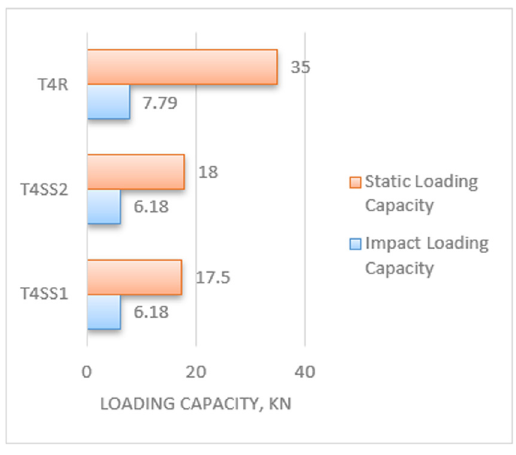
Figure 18: De fl ection of the slabs under impact and static loading.